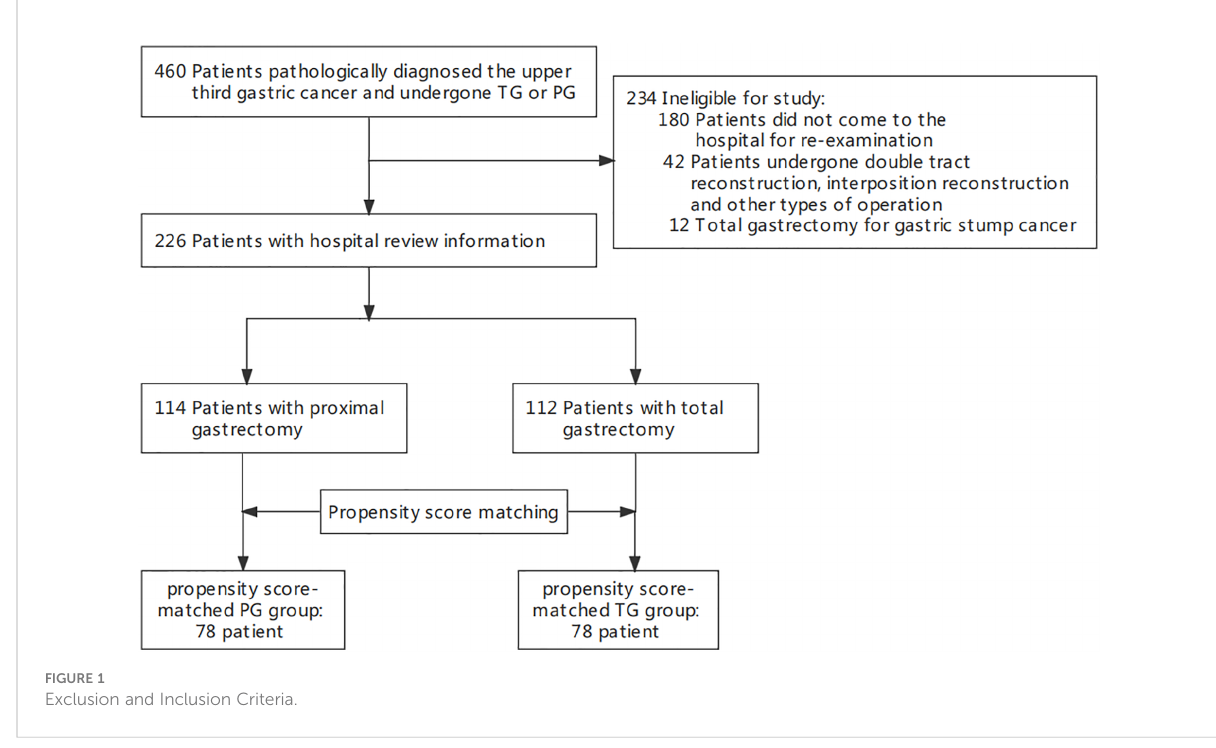
FIGURE 1 Exclusion and Inclusion